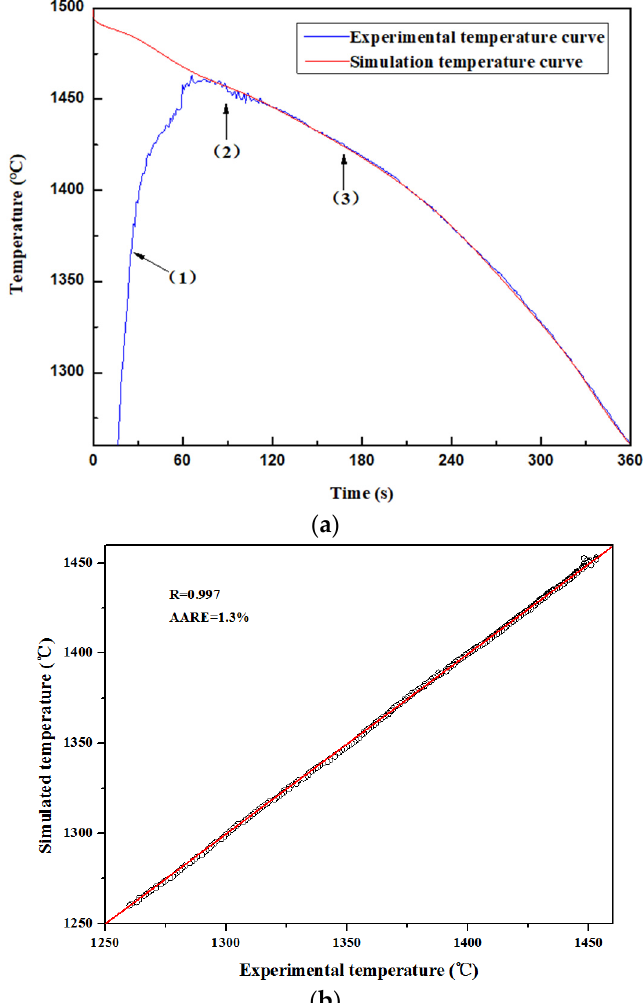
Figure 7. A comparison between the measured and simulation temperatures: ( a ) during